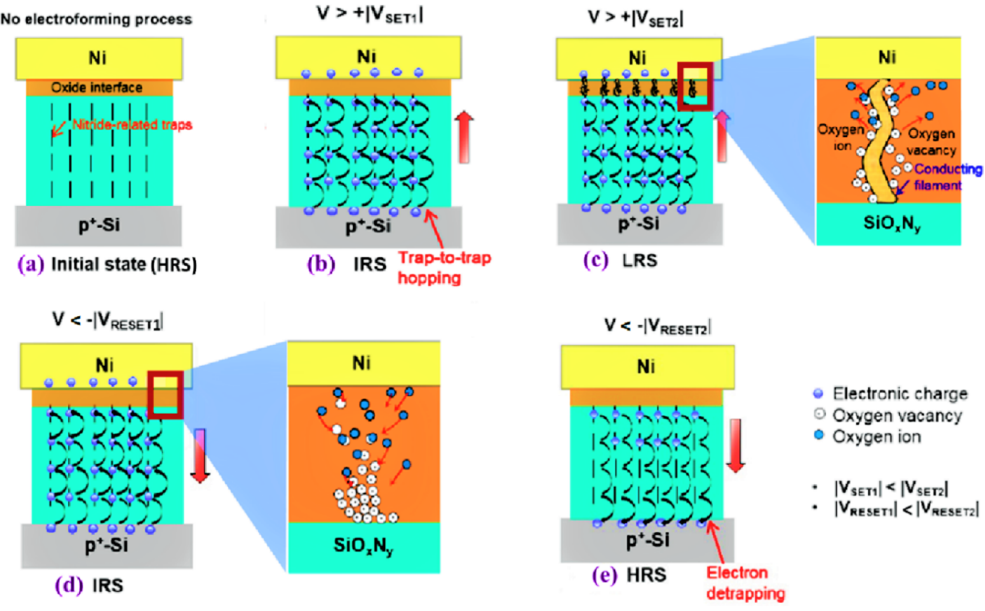
Figure 5. Schematics of the proposed switching mechanism of an Au/Ni/SiO x N y /p + -Si memory